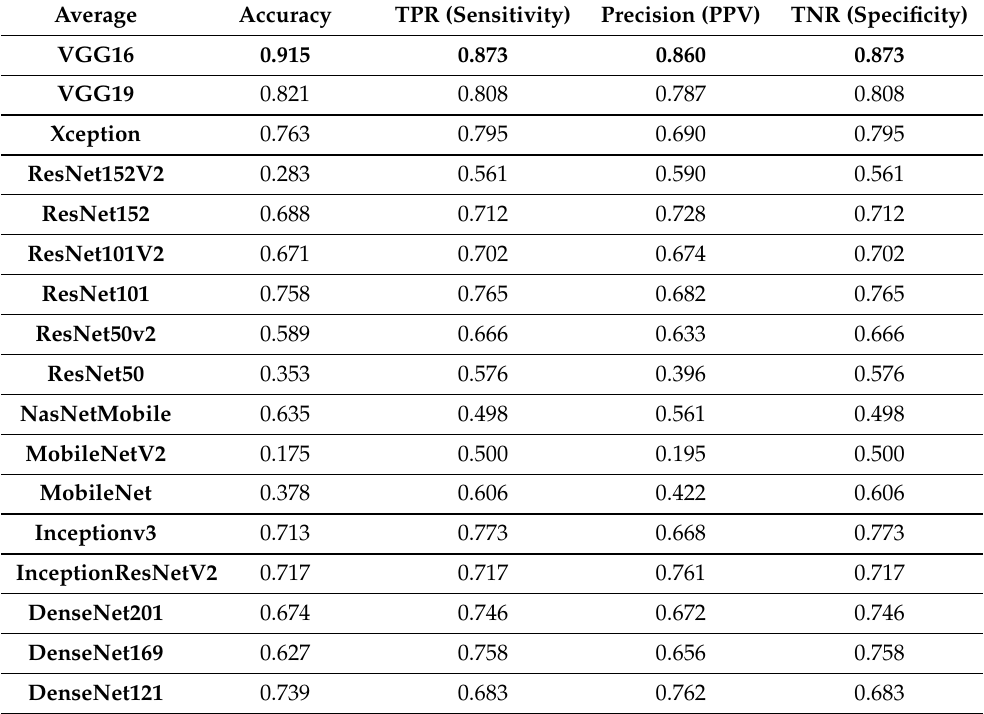
Figure 26. Training time vs. validation accuracy using data selection based on clustering. Table 6. Average metric results related to clustered